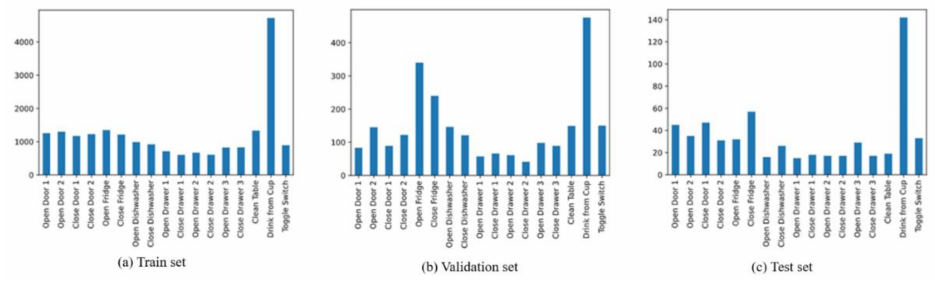
Figure 7. ( a ) Training set distribution without NULL, ( b ) validation set distribution without NULL, ( c ) test set distribution without NULL.